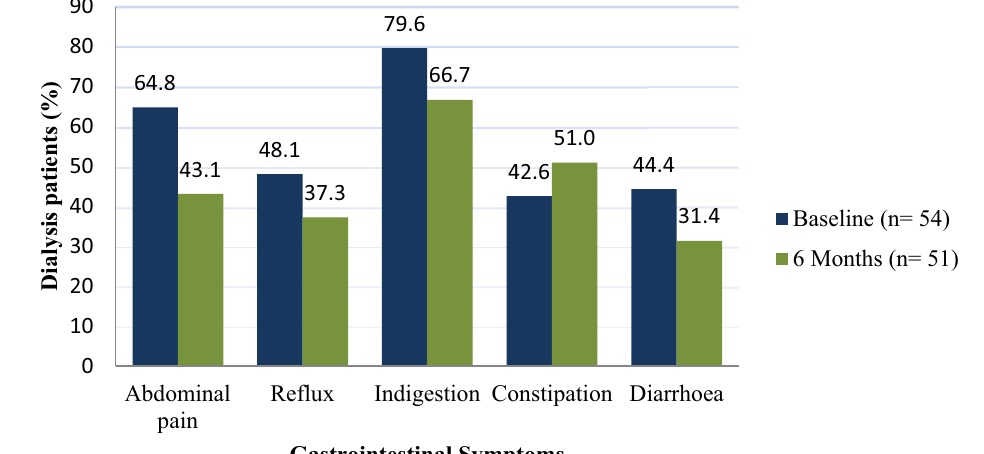
Figure 4. Frequency of gastrointestinal symptoms in transplant candidates at baseline and 6-month follow-up.